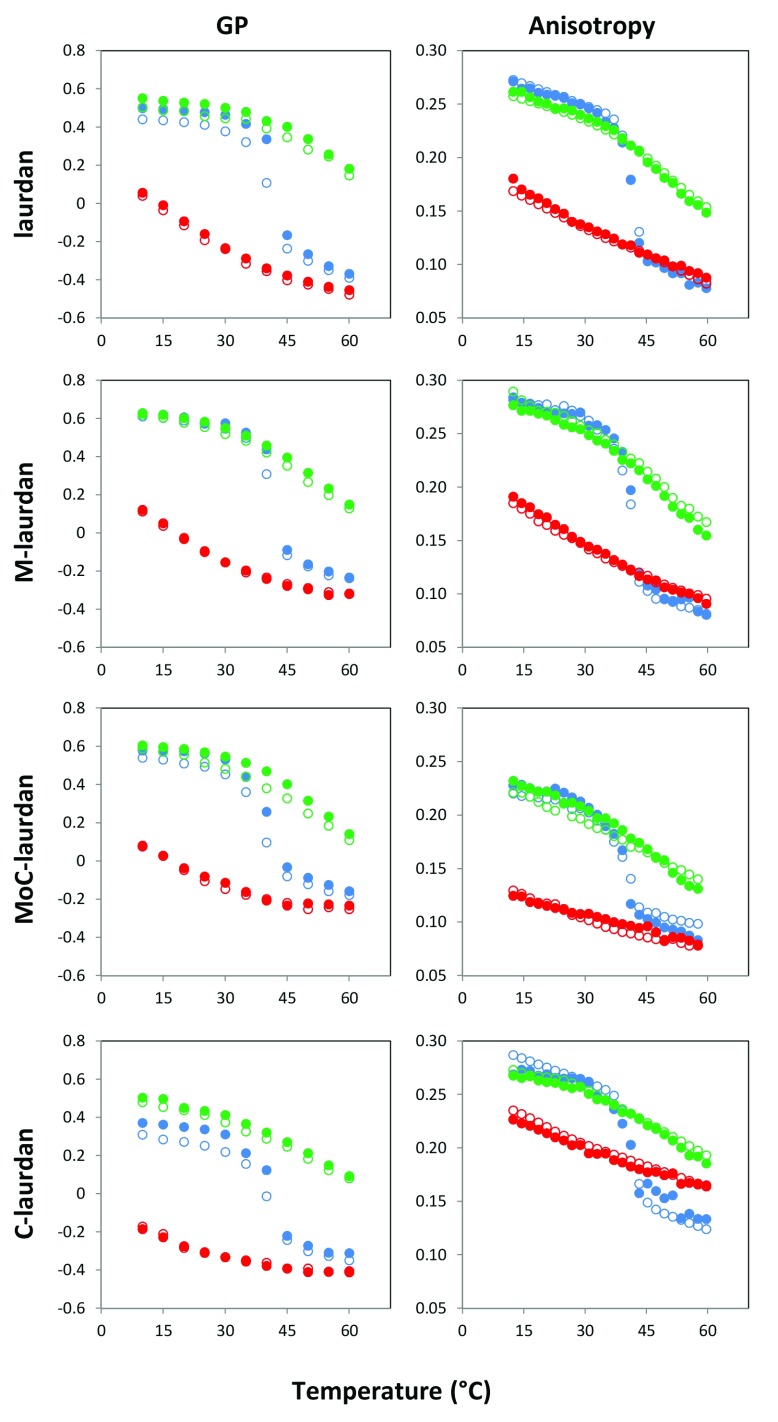
Comparison of GP and anisotropy experiments on LUVS labeled either by direct mixing of lipids and dyes or by the DMSO loading method.LUVs made of DPPC, DPPC/chol (6:4) and POPC (100 µM, sample volume 3 ml) were either prepared in presence of each of the four dyes laurdan, M-laurdan, MoC-laurdan and C-laurdan, or unlabeled LUVs were loaded with the dyes dissolved in DMSO. The final dye concentrations were 1 µM and the DMSO/water ratio 1:1000. GP and anisotropy were recorded as a function of temperature. Symbols: blue for DPPC, green for DPPC/chol (6:4) and red for POPC, filled symbols for LUVs prepared in presence of dyes and open symbol for DMSO loading method. As can be seen from the graphs, the two procedures used to label liposomes with dyes gave extremely similar results.